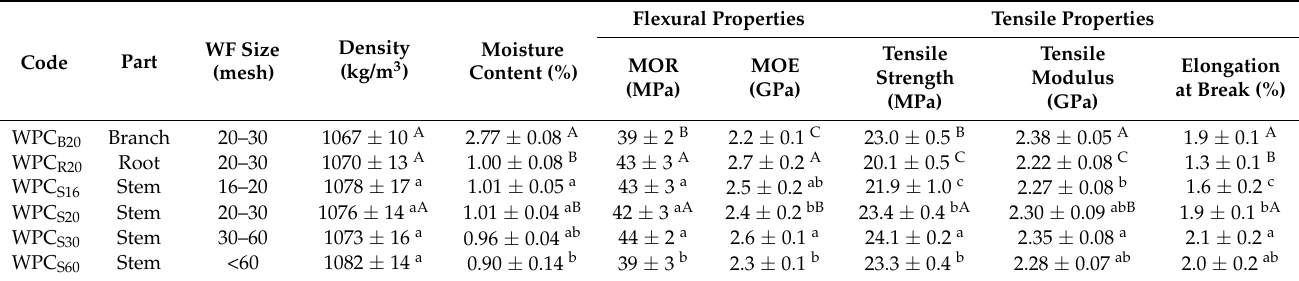
Table 1. Effect of pomelo tree parts and WF sizes on the physical, flexural, and tensile properties of